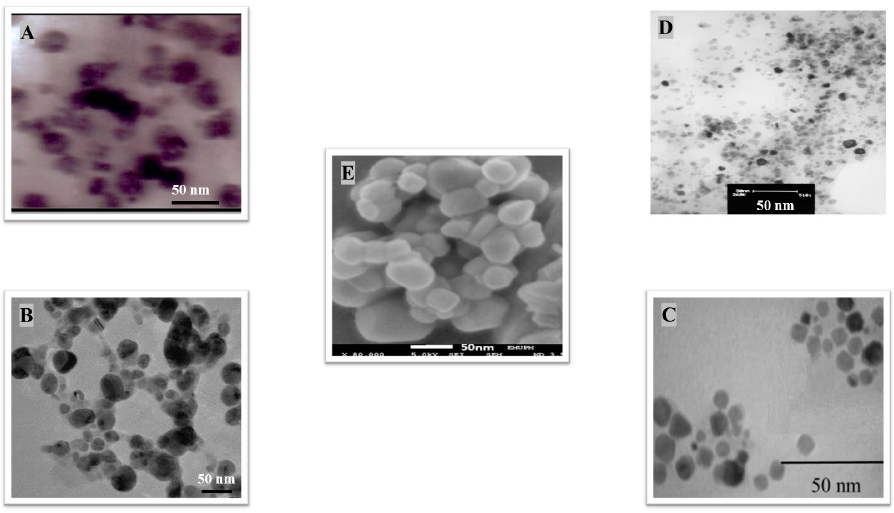
Figure 2. TEM images of various metallic nanoparticles (NPs). ( A ) Cadmium sulfide NPs (CdSNPs) by Phormidium tenue [90], ( B ) copper oxide NPs (CuONPs) by Bifurcaria bifurcata [92], ( C ) iron oxide NPs (Fe 2 O 3 NPs) by Sargassum muticum [94], ( D ) palladium NPs (PdNPs) by Spirulina platensis [97], ( E ) zinc oxide NPs (ZnONPs) by Sargassum muticum [99]. (Copyright permission has been granted for each figure).